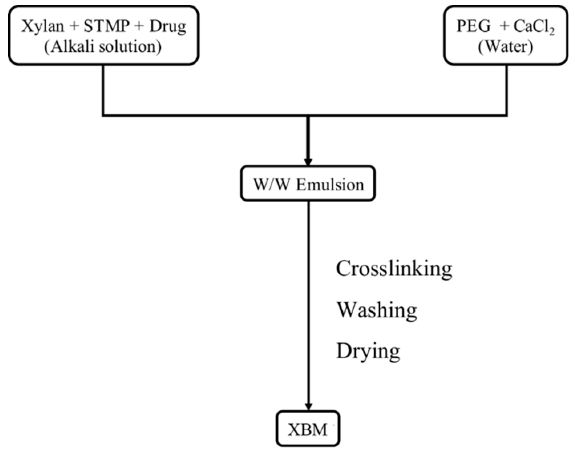
Figure 1. Flow chart for the production of the xylan-based microparticles (XBM) and XBM-Ca. STMP = Sodium trimethaphosphate. PEG = Polyethylene glycol. MW = 20,000. CaCl 2 = Calcium chloride.